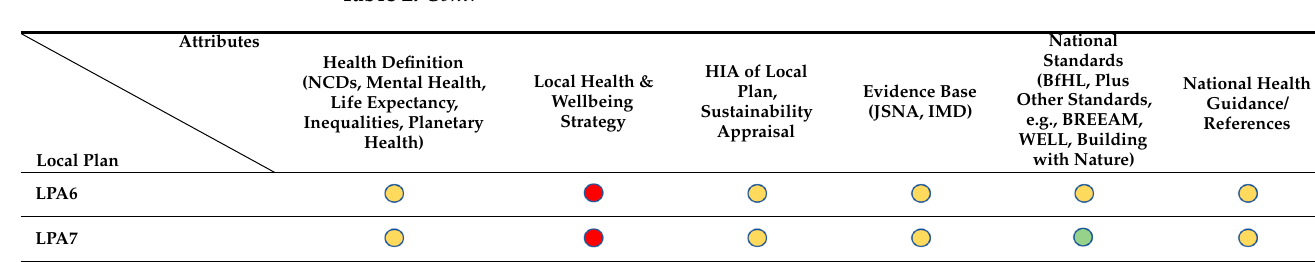
Table 3. Local plans and health requirements for developers.